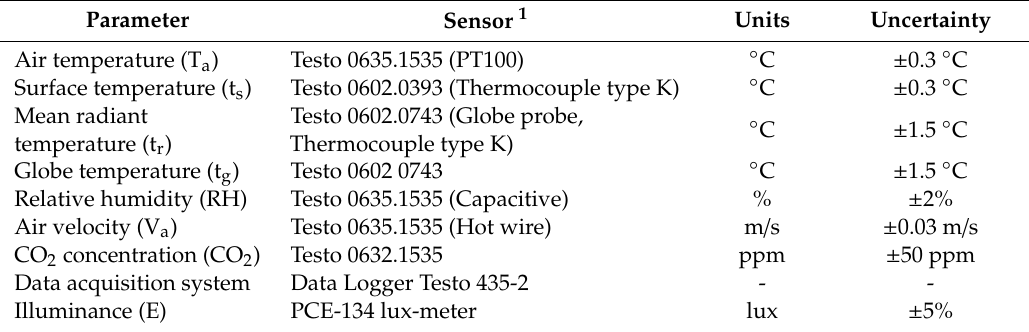
Table 3. Characteristics and uncertainty of the sensors used for on-site measurements.